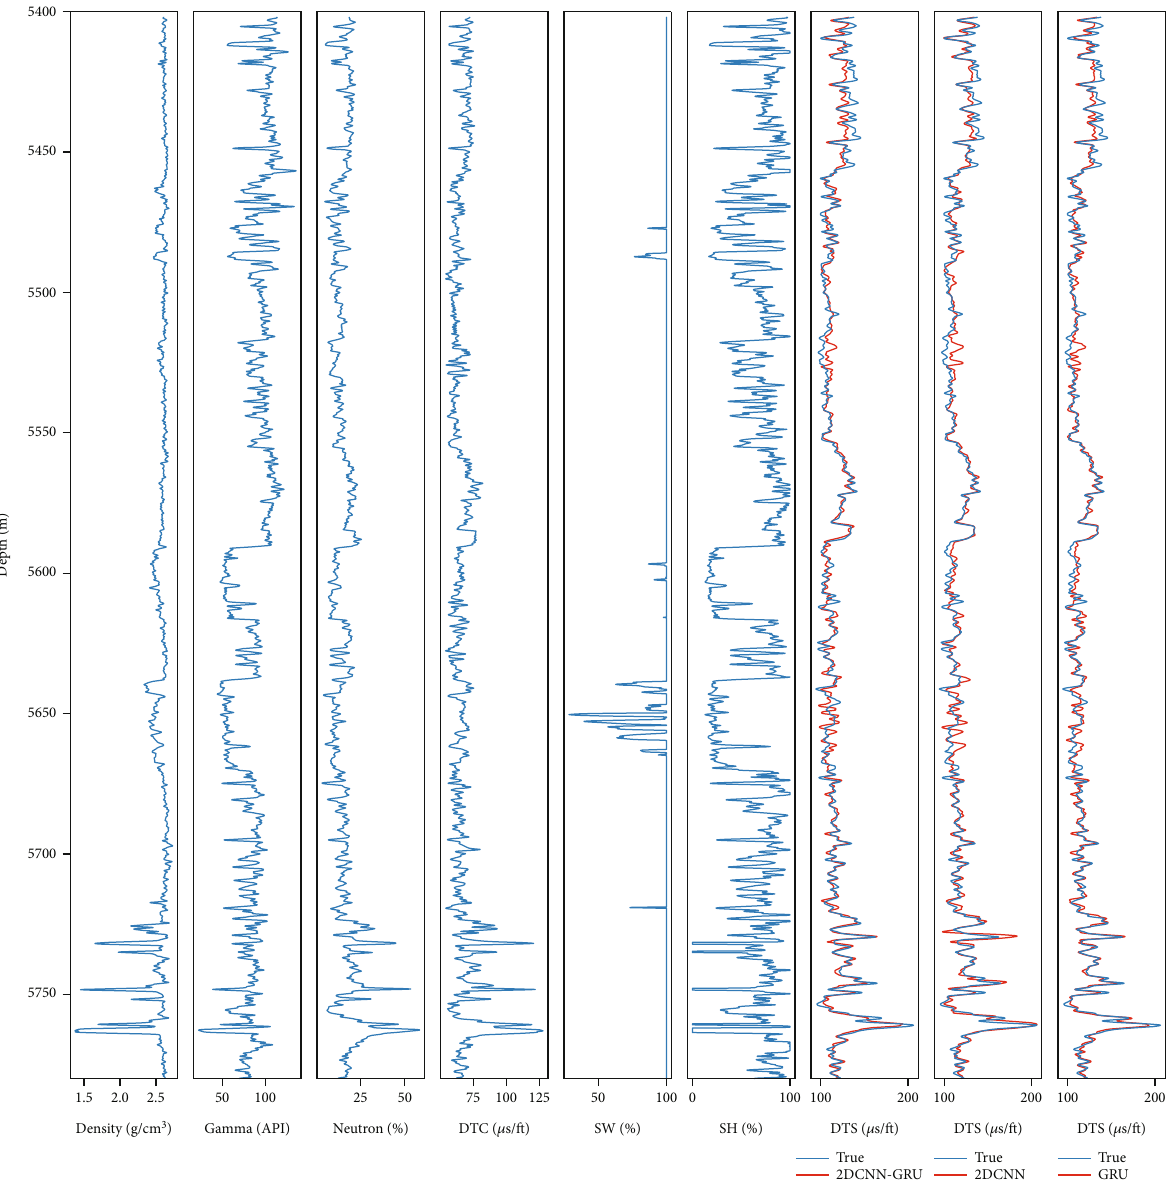
Figure 9: Prediction results of three networks in case I. The last three subgraphs indicate the fi nal prediction results. The blue line represents the true values and the red line represents di ff erent prediction results based on three networks. The left one is the prediction result from 2DCNN-GRU, the middle one is that from 2DCNN, and the right one is that from GRU. To analyze the prediction performance of the three networks more clearly, the di ff erences between the prediction of the three networks were compared in the form of local ampli fi cation (Figure